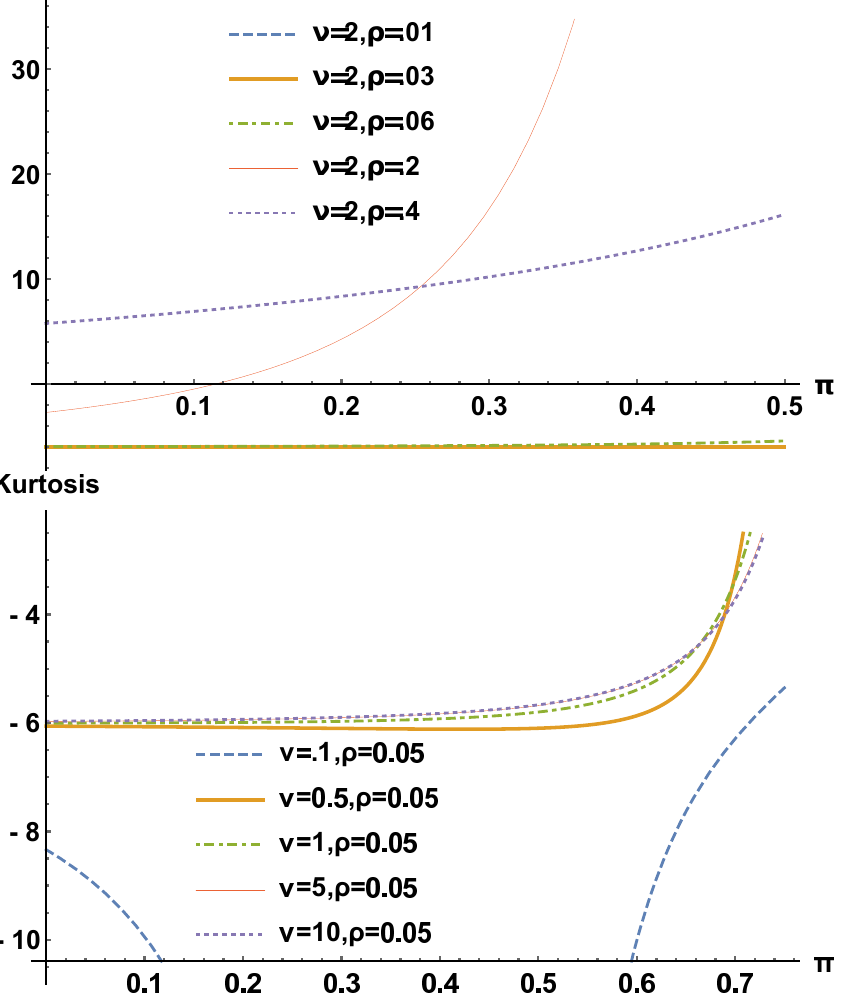
Now, equating the coefficients of t 0 on both sides of (20) we get (15), and on equating the coefficients of t w on both sides of (20), we get